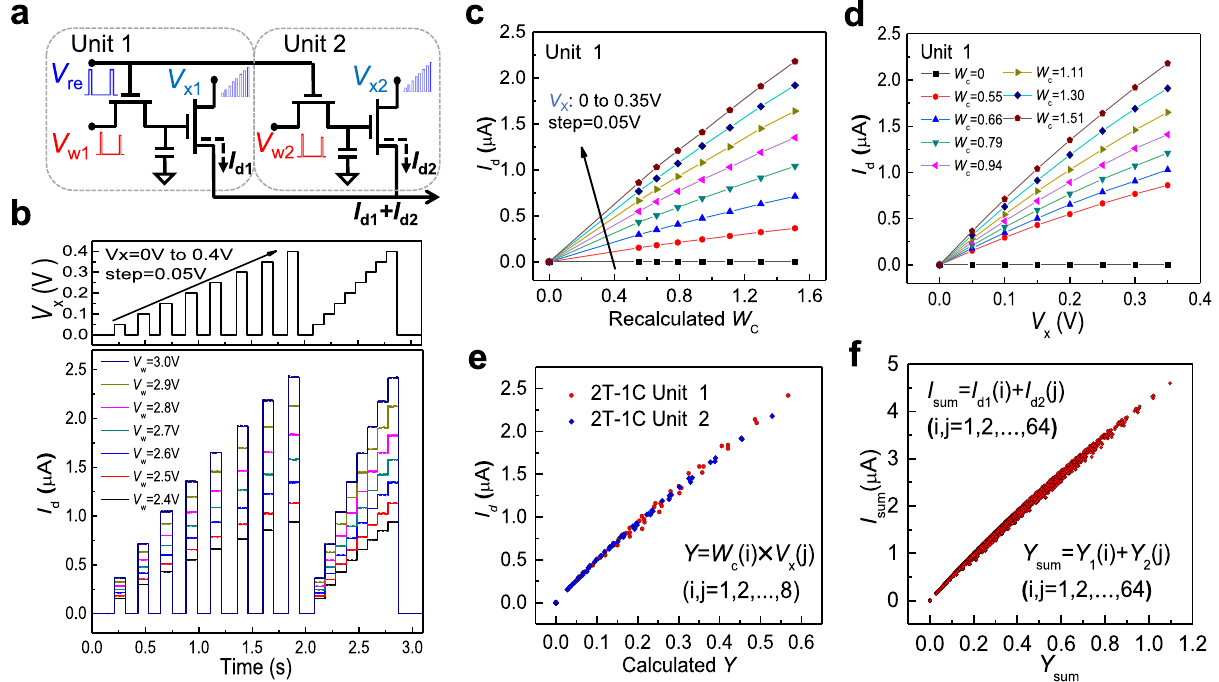
Fig. 4 Demonstration of multiply accumulate operation using two 2T – 1C cells. a Schematic showing two identical 2T-1C cells. The sources of the two cells are connected to sum the drain current. b Top graph: a test multi-step voltage waveform applied to V x , ranging from 0.005 to 0.35 V with 0.05 V increments. The pulse width is 0.1 s. Bottom graph: The corresponding I d waveform, while V w is fi xed at a series of values. Both V x and V w exhibit eight distinguishable voltage levels (3 bits). c The output current I d as a function of W c , and the fi xed input V x ranges from 0 to 0.35 V with 0.05 V increments. d The output current I d is plotted as a function of V x under different W c values. e The measured I d values as a function of their calculated Y ( W c × V x ) for two different 2T – 1C cells on one MoS 2 wafer. f The total output current I sum as a function of Y sum from the two different 2T – 1C cells.